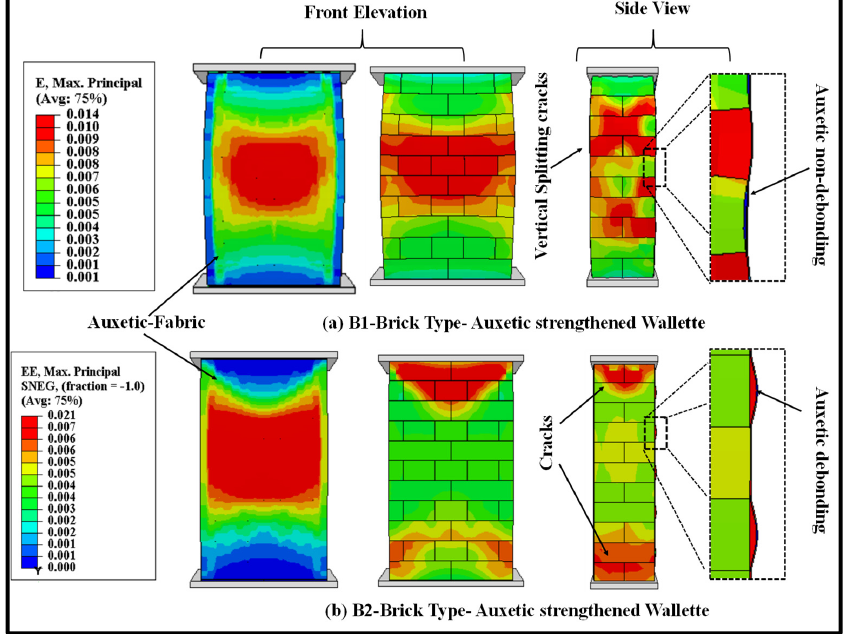
Figure 19. Numerically predicted damage on the surface of the auxetic fabric and masonry wallettes